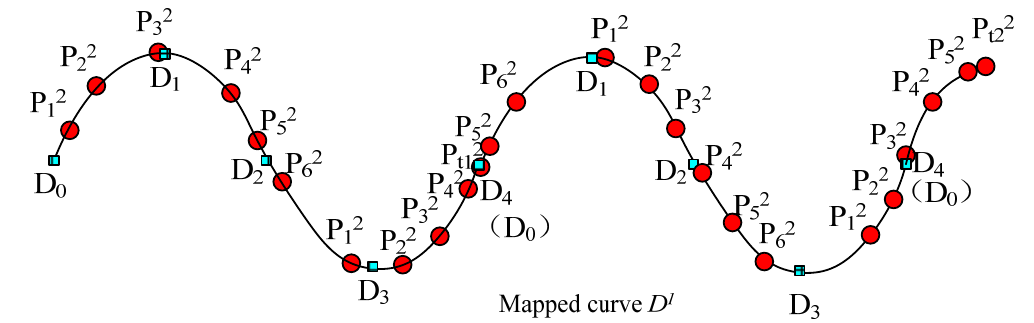
10 of 27 Figure 9. The mapping result for the different starting points.